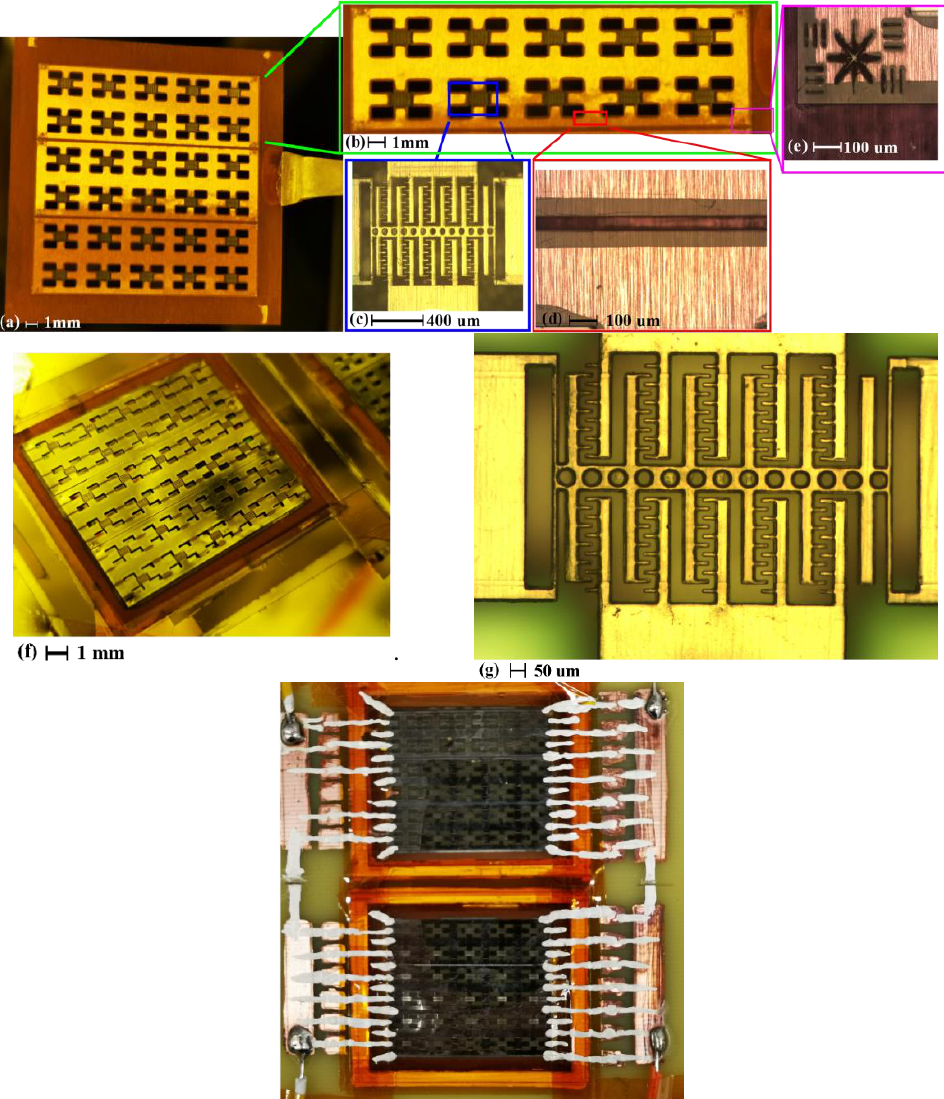
Figure 7. Optical views of the proof-of-concept transducers. ( a ) After releasing through copper etching; ( b ) Zoom-in view of 10 structures; ( c ) Zoom-in view for one structure after releasing before sputtering; ( d ) to ( e ) Overhangs formed by copper etching at different locations; ( d ) at the electrode separation gap; ( e ): at the left bottom corner; ( f ) 30 structures after sputtering; ( g ) Zoom-in view of one single transducer after sputtering; ( h ) 60 proof-of-concept structures after packaging for electrical-mechanical characterization.